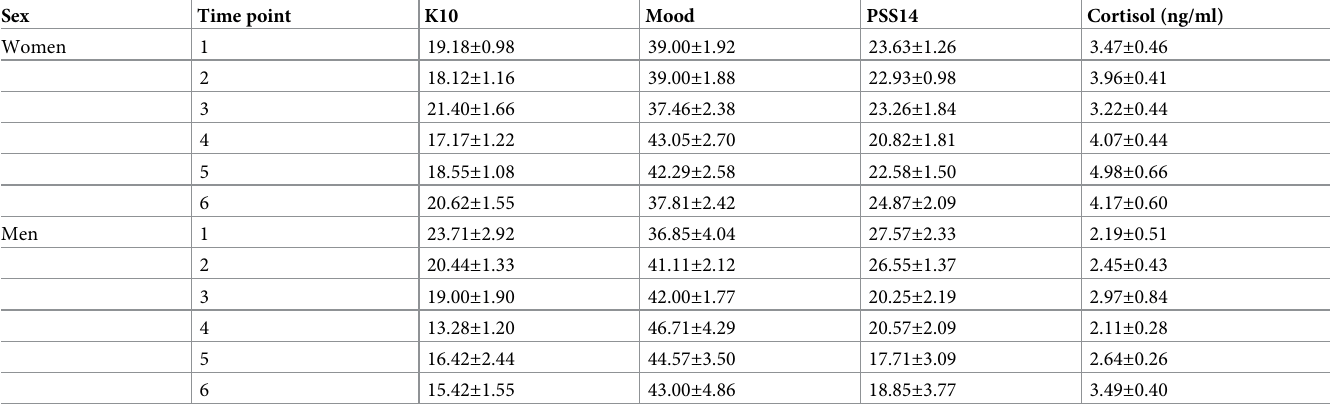
Table 1. Mean ± SE of all psychological (K10, Mood, PSS14) and physiological (cortisol) parameters for both sexes.